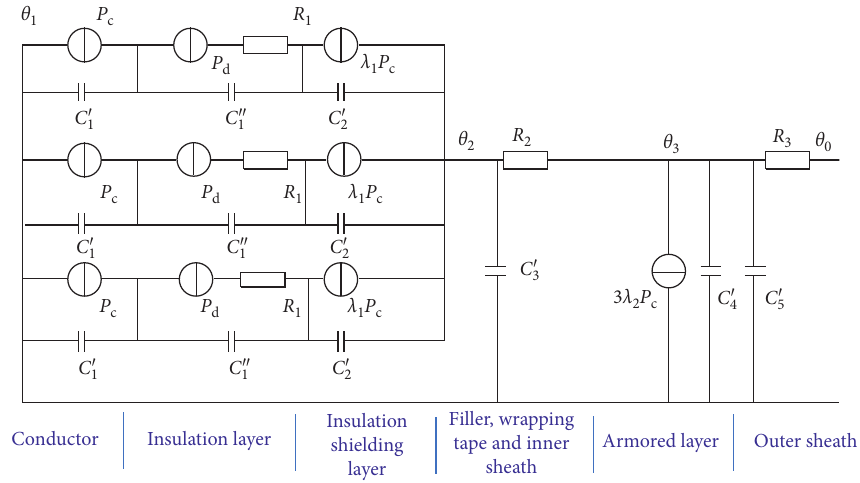
Figure 4: Transient thermal circuit model of power cable.